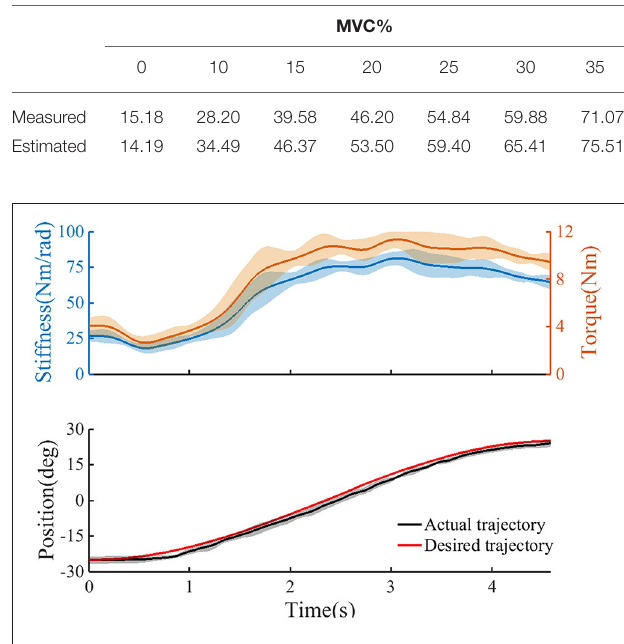
FIGURE 4 | The trajectory tracking task without provided assistance ( n trials); Top : the estimated user’s torque, and the estimated joint stiffness. Bottom : the ankle angle as recorded from the device. Continuous line, average curves; shaded area, standard